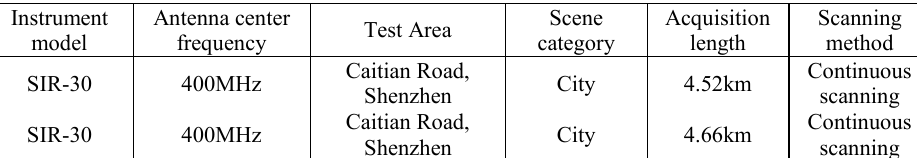
Table.1 GPR equipment and test area